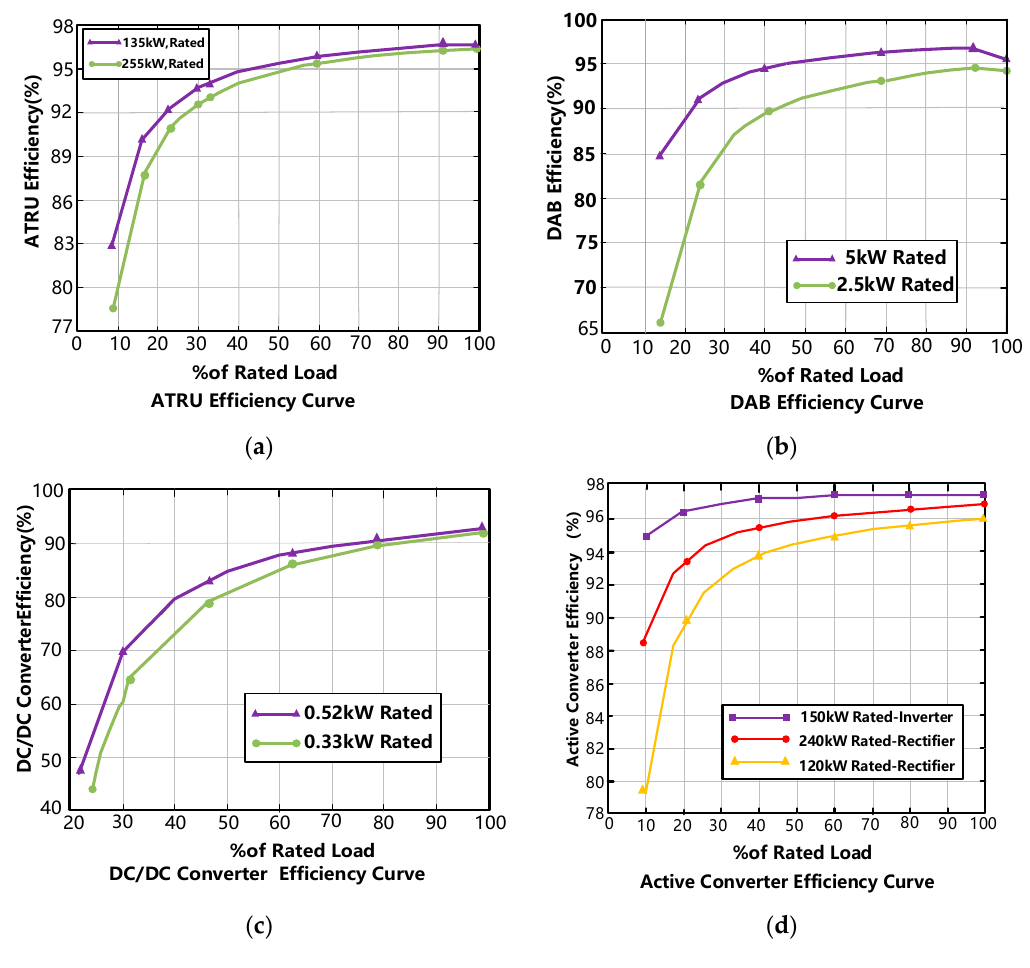
Figure 3. The efficiency curve of typical electrical power converter components in aircraft. ( a ) ATRU efficiency curve. ( b ) DAB efficiency curve. ( c ) DC/DC converter efficiency curve. ( d ) Active converter efficiency curve.